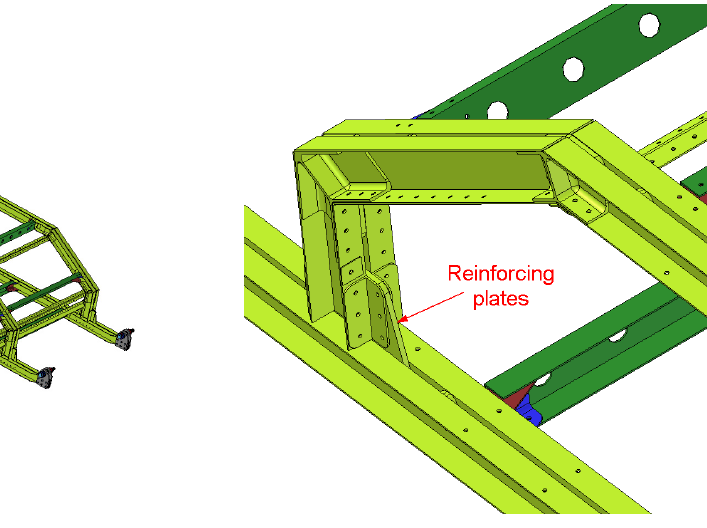
Figure 3: Principal frame of the roof module. Figure 4: Reinforcing